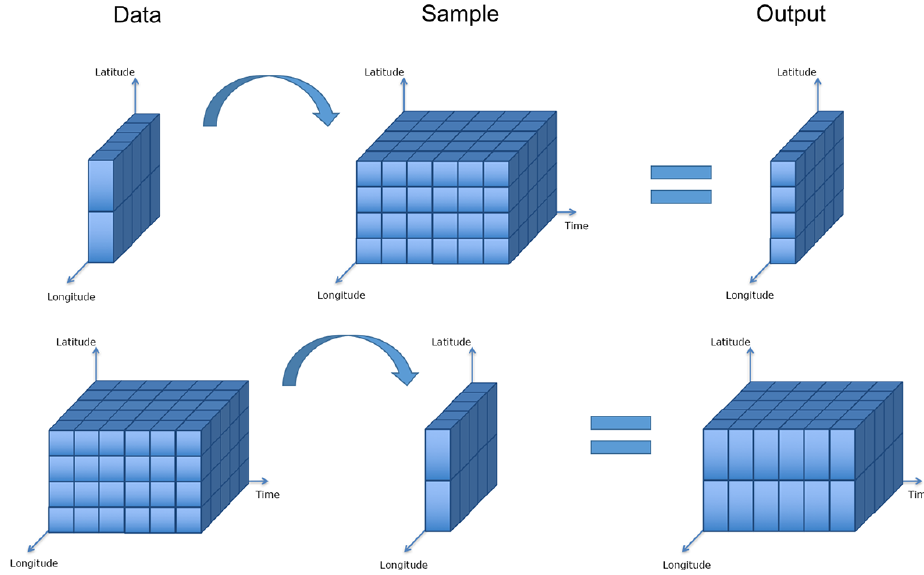
Figure 4. This schematic shows the collocation of gridded data onto a gridded sampling with differing dimensionality. The output dimen- sionality is always the same as that of the input data.